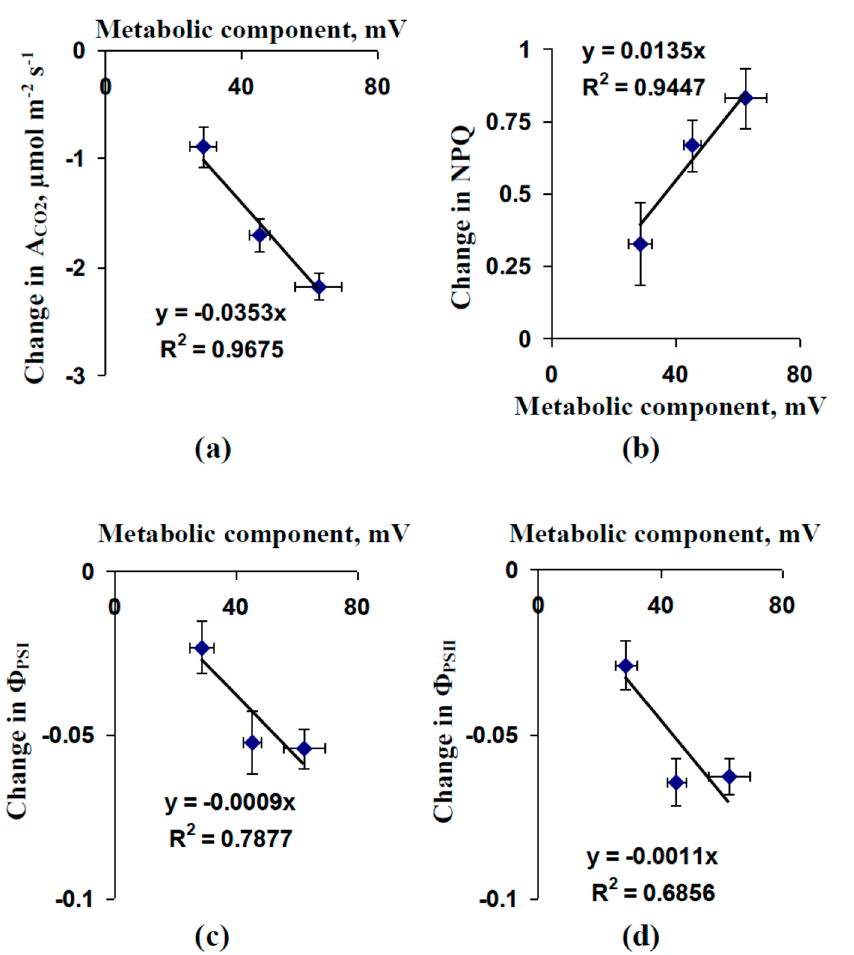
Figure 5. Scatter plots between the values of the metabolic component of the membrane potential and magnitudes of local burning-induced changes in photosynthetic CO 2 assimilation (A CO2 ) ( a ), non-photochemical quenching of chlorophyll fluorescence (NPQ) ( b ), and quantum yields of photosystems I ( Φ PSI ) ( c ) and II ( Φ PSII ) ( d ), in the second leaf of pea seedlings. Data from Figures 1 and 3 were used.